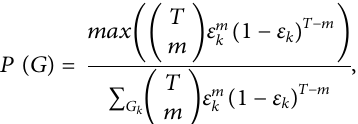
Frontiers in Genetics |